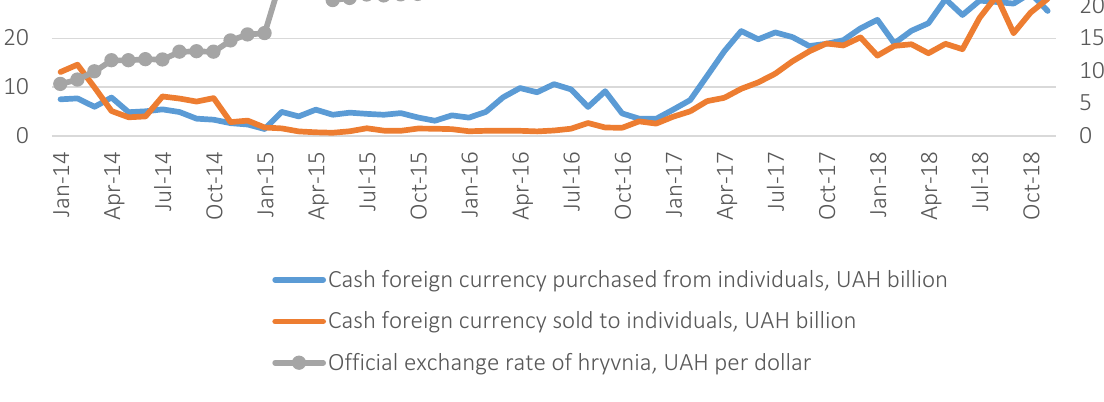
Figure 6. Currency market information, 2014–2018